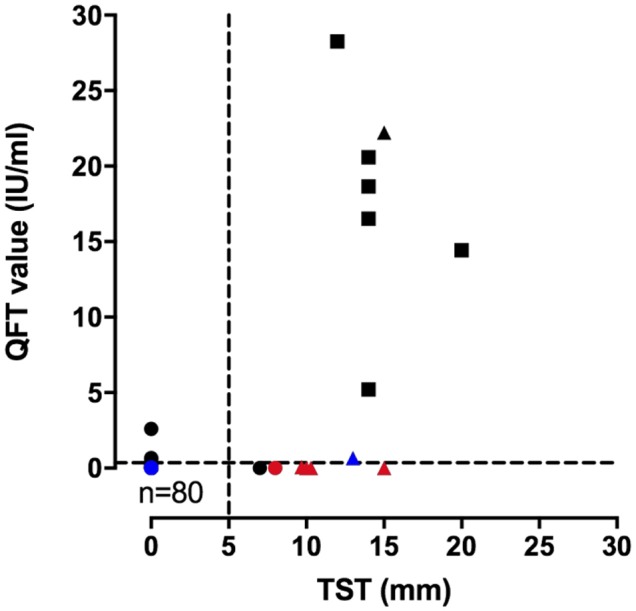
Correlation of QuantiFERON interferon-γ values (IU/ml) and TST diameter of induration (mm). The results of the QuantiFERON interferon-γ values and the TST diameter of induration were compared for 97 samples including 52 children diagnosed as not infected (•), but 85 samples; five children with a diagnosis of latent tuberculosis infection (▴), but six samples; four children with a diagnosis of pulmonary TB (◾), but six samples. BCG-vaccinated children were identified with a red color, BCG-unvaccinated children with a black color, and unknown BCG status children with a blue color. Each dot corresponds to a single sample. The value of the r Spearman correlation index is 0.36 (95% confidence interval 0.17–0.53).